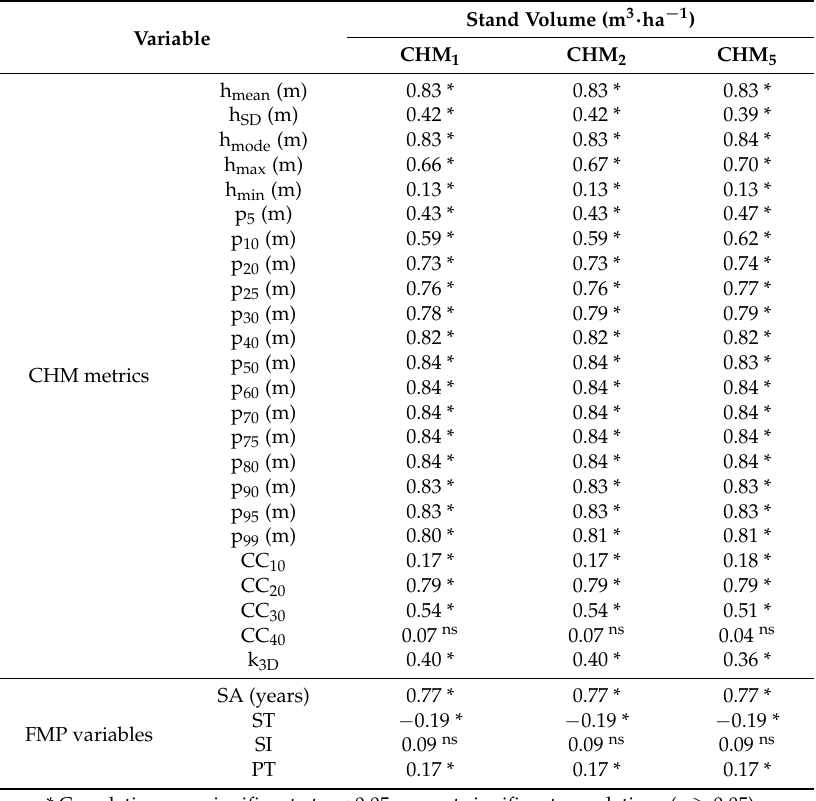
Table 5. Pearson correlation coefficients (r) between the potential predictors (CHM metrics and FMP variables) and stand volume from field measurements calculated on the modeling